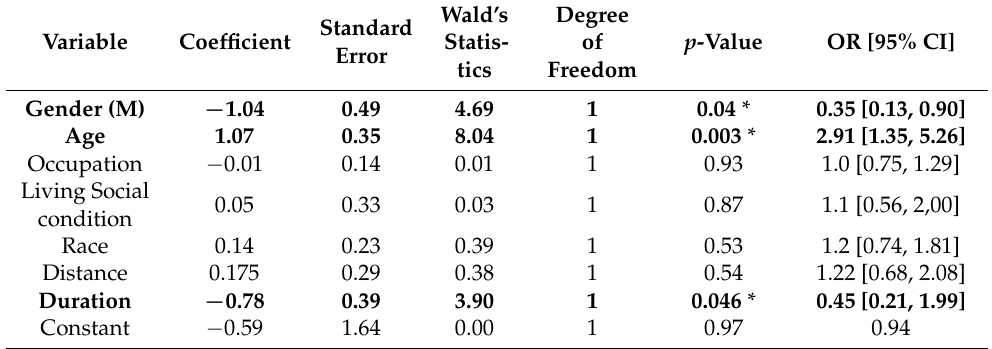
Table 4. Binary Logistic regressions results between doses, demographics, and high-risk WHR. Standard Variable Coefficient